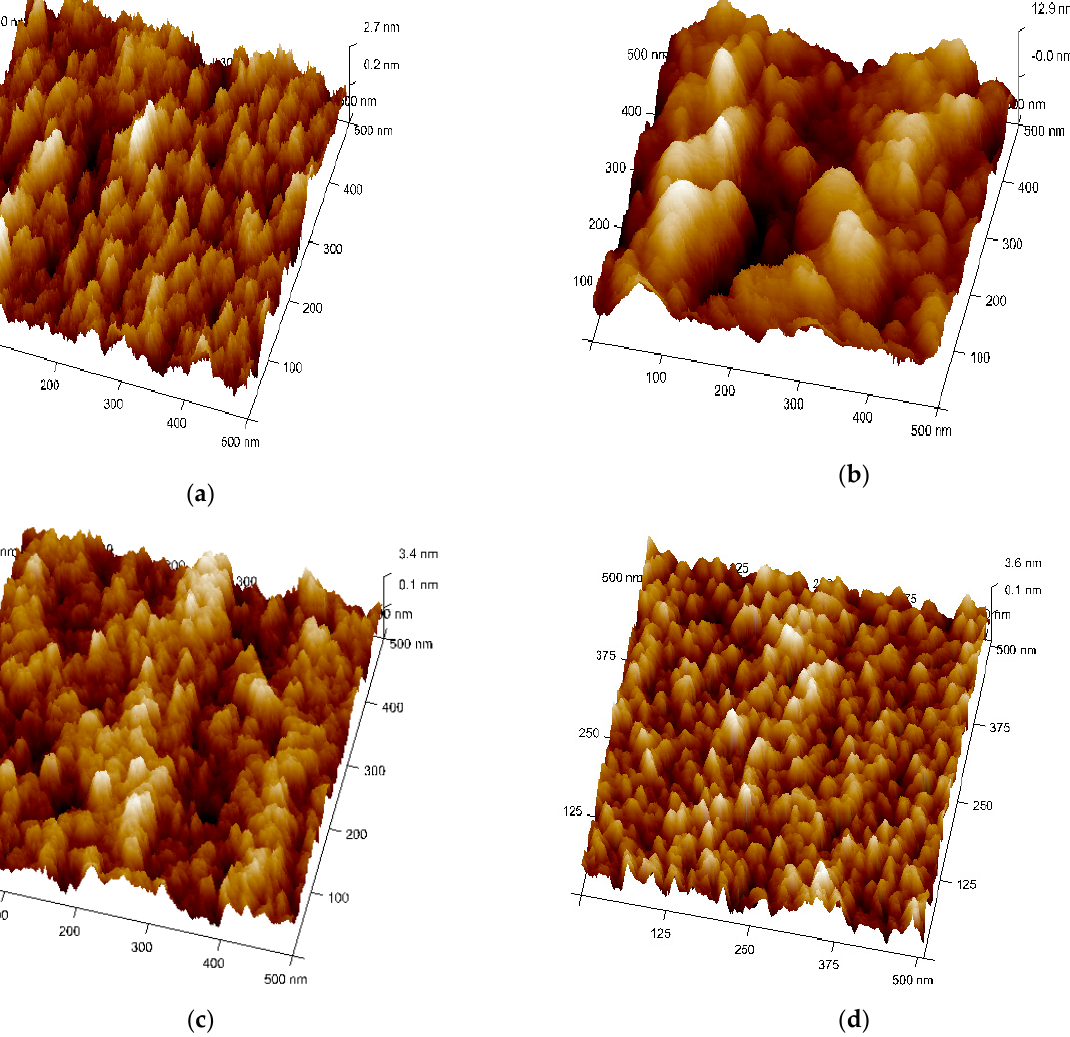
Figure 4. Topographical view of Ag–WO 3 films at ( a ) 0%, ( b ) 1%, ( c ) 3%, and ( d ) 5% Ag concentra-